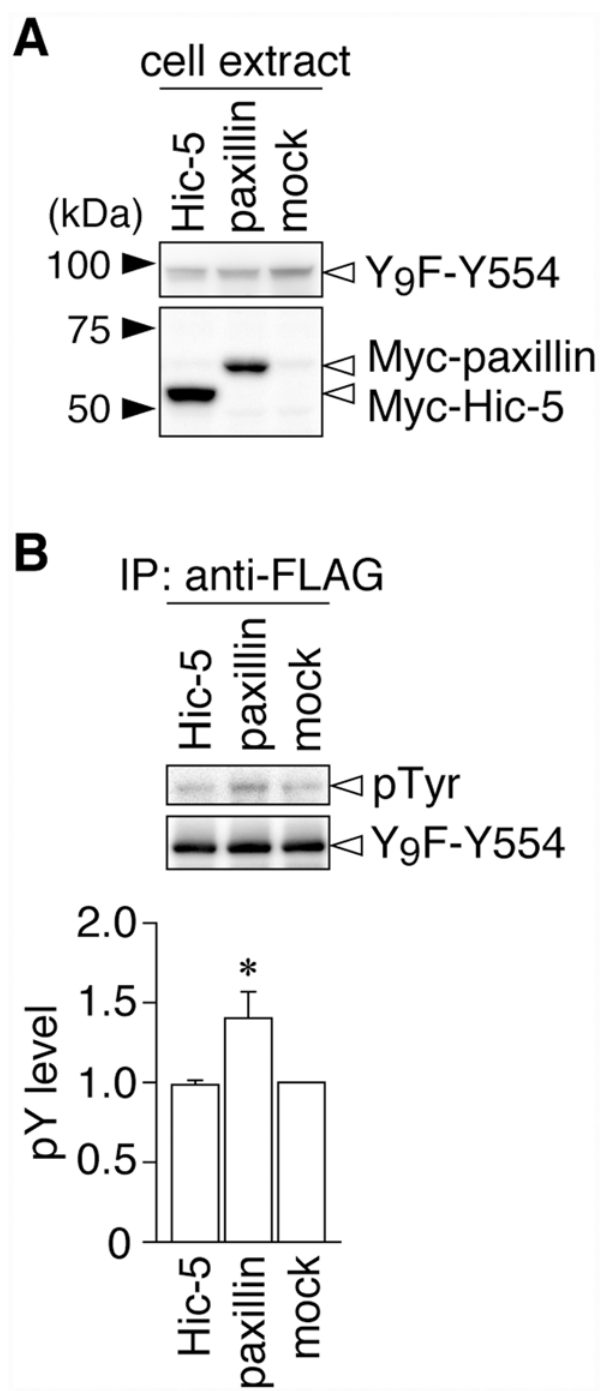
Fig 4. Git1 phosphorylation at Tyr-554 was enhanced by co-expression of paxillin. A , Western blotting of protein expression levels in HEK293T cells exogenously expressing the FLAG-tagged Git1-Y 9 F-Y554 mutant together with Myc-tagged paxillin, Myc-tagged Hic-5, or a control mock. B , Tyrosine phosphorylation of Y 9 F-Git1 proteins in anti-FLAG immunoprecipitates. The lower graph shows the densitometric analysis of the Western blotting data. Data are the mean ± S.E. (error bars; n = 3). * , P < 0.05 significantly different from Hic-5-transfected cells by ANOVA with Fisher ’ s PLSD post hoc tests.